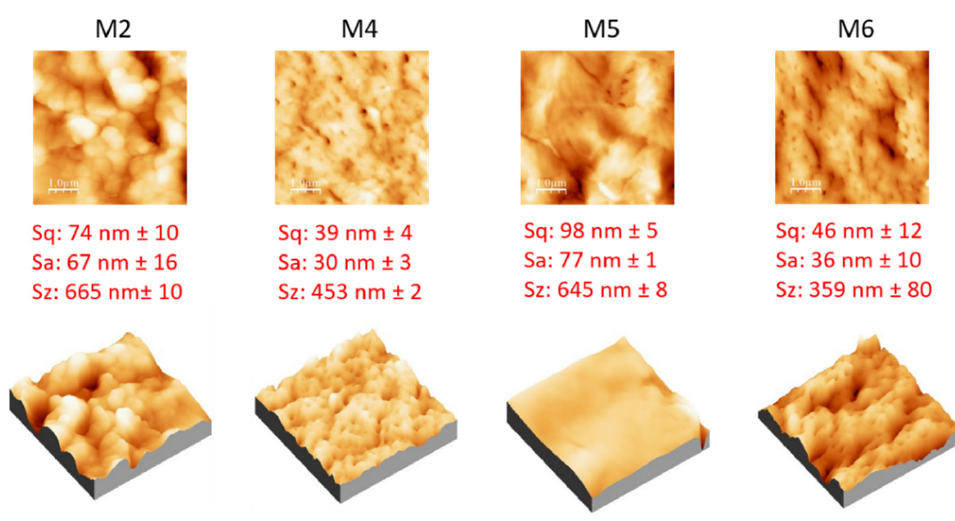
Figure 4. AFM images, with corresponding 3D views, and roughness parameters of M2, M4, M5 and M6 membranes.